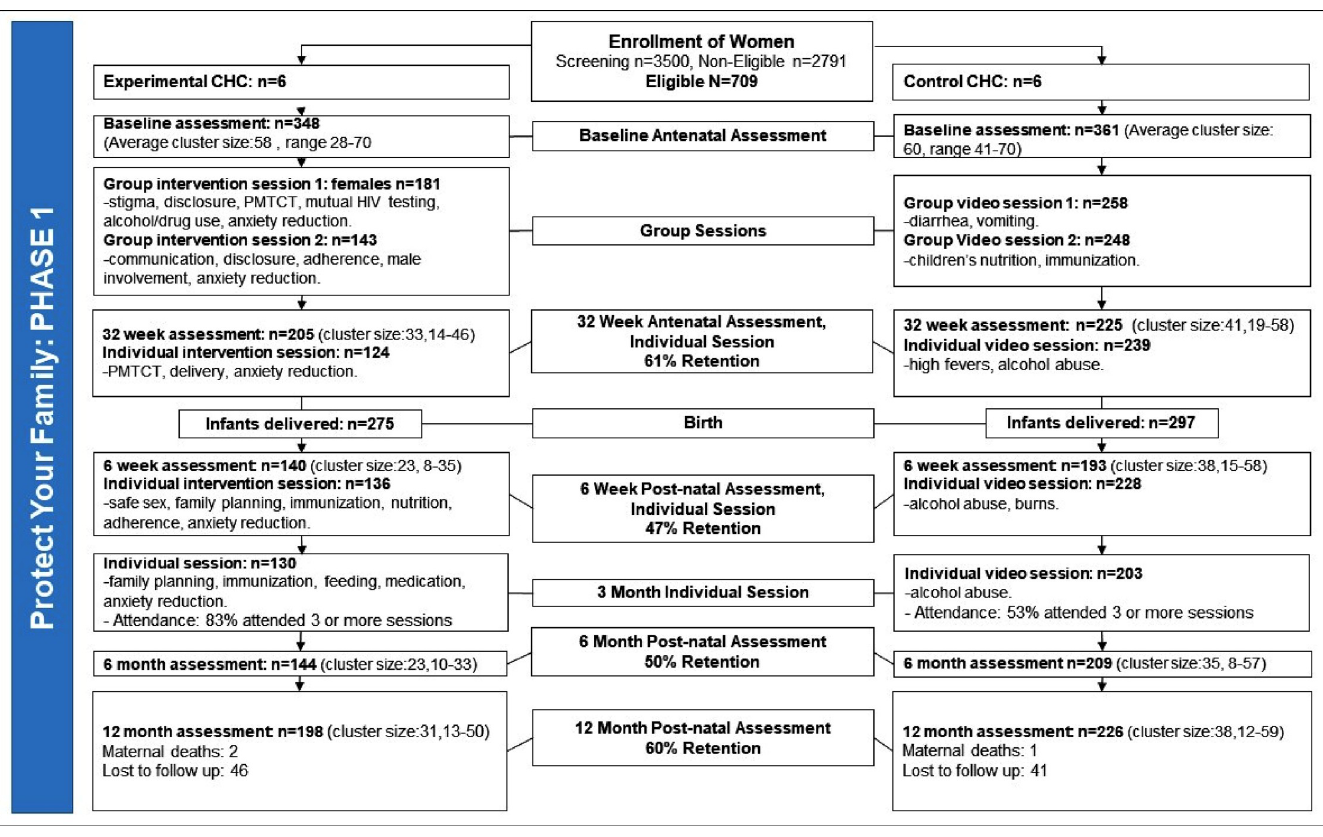
Fig 1. CONSORT diagram outlining enrolment procedures for Phase